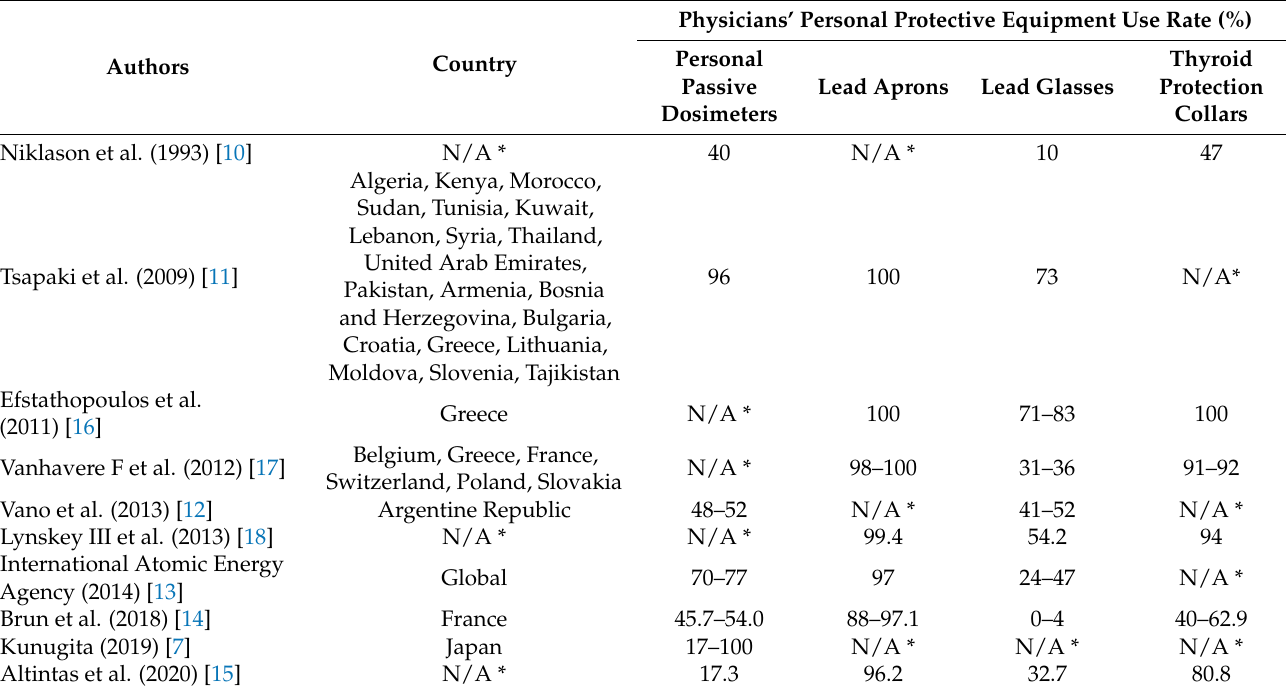
Table 2. Past reports on the use rate of PPE by